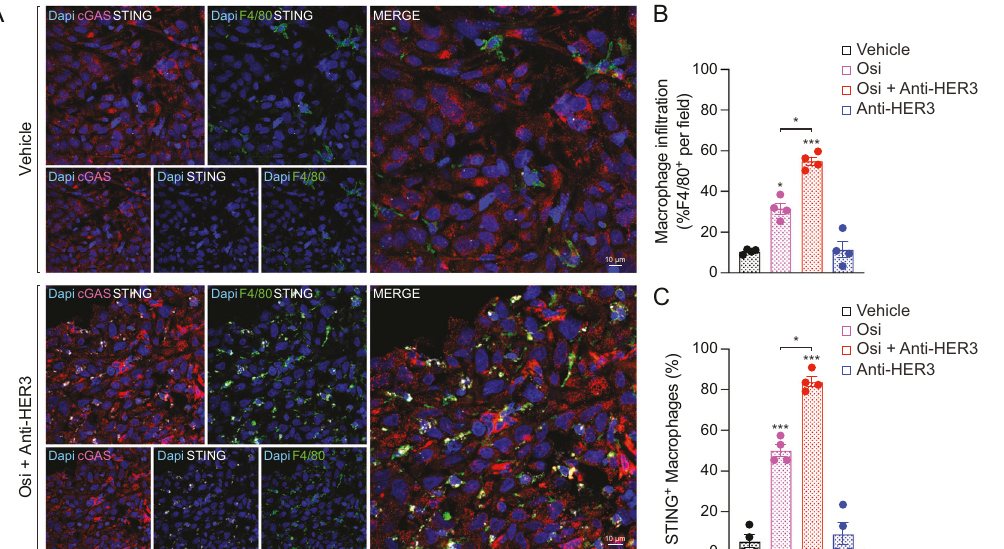
Fig. 5 Osimertinib and anti-HER3 therapy combination increases STING in tumor in fi ltrating macrophages. A Confocal immuno fl uor- escence images from xenograft tumor slices, showing cGAS distribution (red), in fi ltrating macrophages (F4/80, green), STING (white) and nuclei (Dapi, blue). Images are representative from treatment groups indicated (de fi ned in Fig. 4A; all groups shown in Supplementary Fig. S6). White scalebars are indicated in merged channel images. B In fi ltrating macrophages (F4/80 + ) were quanti fi ed vs . total cell number (Dapi) using Fiji-ImageJ. Data shown as mean ± SEM from image fi elds corresponding to the treatment groups indicated (de fi ned in Fig. 4A). Statistical analysis using one-way ANOVA with Tukey ’ s multiple group comparison test revealed * P < 0.05 and *** P < 0.001 relative to vehicle or as indicated. C STING-positive macrophages (STING + and F4/80 + ) were quanti fi ed vs . total macrophage number (F4/80 + ) using Fiji-ImageJ. Data shown as mean ± SEM from 4 independent image fi elds coming from the treatment groups indicated (de fi ned in Fig. 4A). Statistical analysis using one-way ANOVA with Tukey ’ s multiple group comparison test revealed *** P < 0.001 relative to vehicle or * P < 0.05 and as